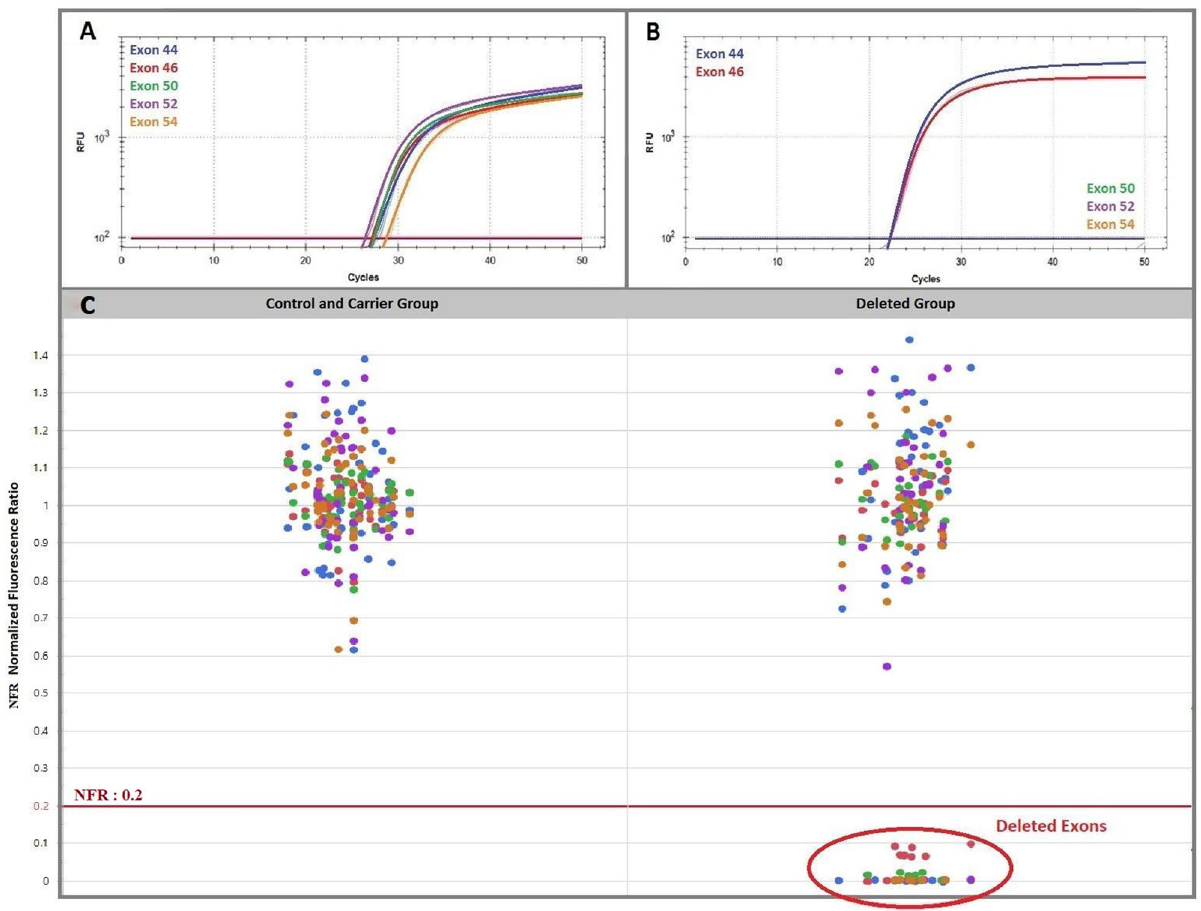
Figure 2. Amplification curves and scattered endpoint fluorescence of control group and carrier group, and DMD patients with a deletion of at least one target exon (deleted group). ( A ) Amplification curves of a patient without deletion of any target exons. ( B ) Amplification curves of a patient with a deletion of exons 50 to 54. ( C ) Normalized Fluorescence Ratio (NFR) of control and carrier group versus deleted group (i.e. DMD patients with a deletion overlapping at least one of the five target